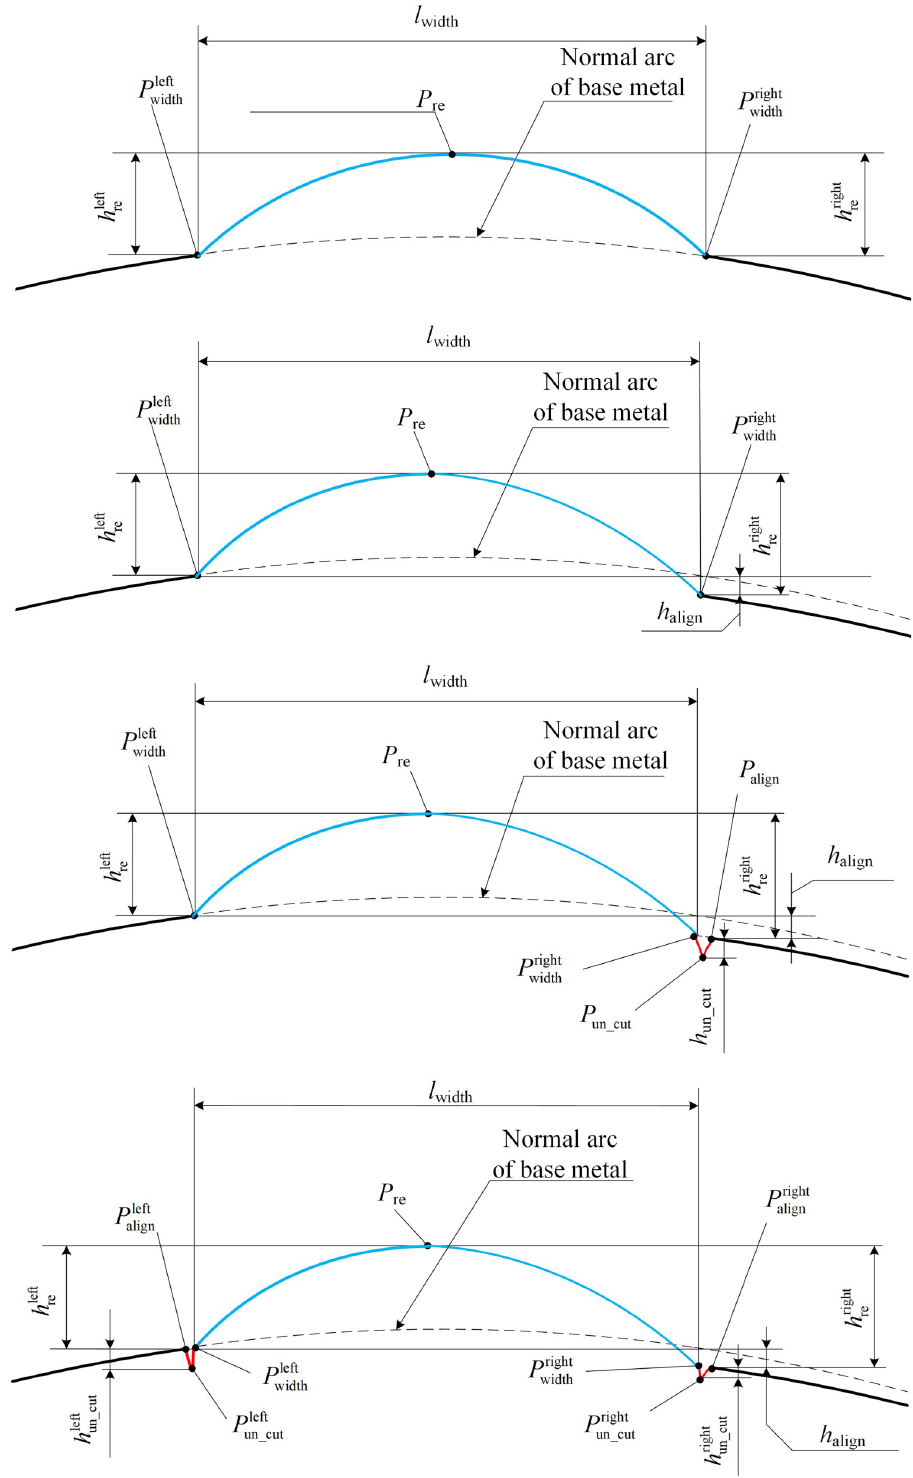
Fig 4. Schematic diagrams of welding seam parameter measurement index under different welding seam shapes. (a) Normal weld. (b) Welds with the wrong sides. (c) Welds with single undercut and misalignment. (d) Welds with double undercut and